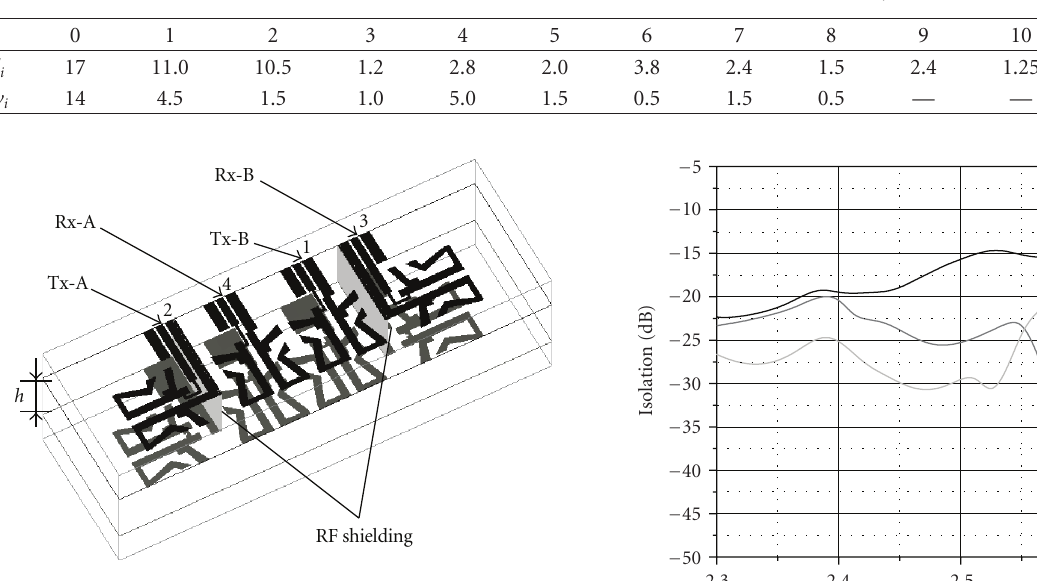
Table 3: d i and w i values, measured in mm, for the three antennas system.